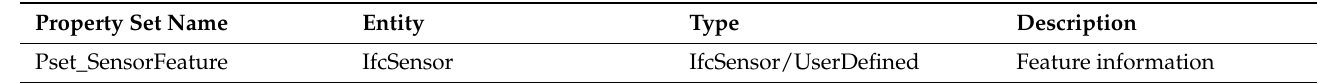
Table 1. Pset_SensorFeature Property Set Definition.